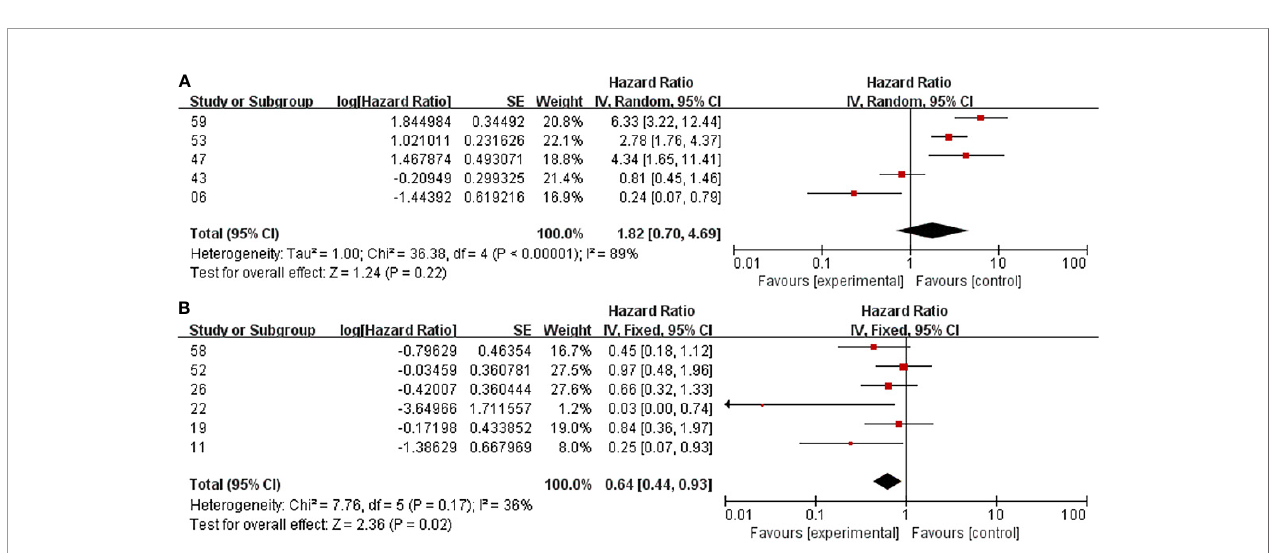
FIGURE 5 | Funnelplot after sensitivity analysis. Surgery+RT vsSurgery,PFS (A) . Surgery+RT vsSurgery, OS (B) . GTR+RT vsGTR, PFS (C) . STR+RT vs STR,PFS (D)